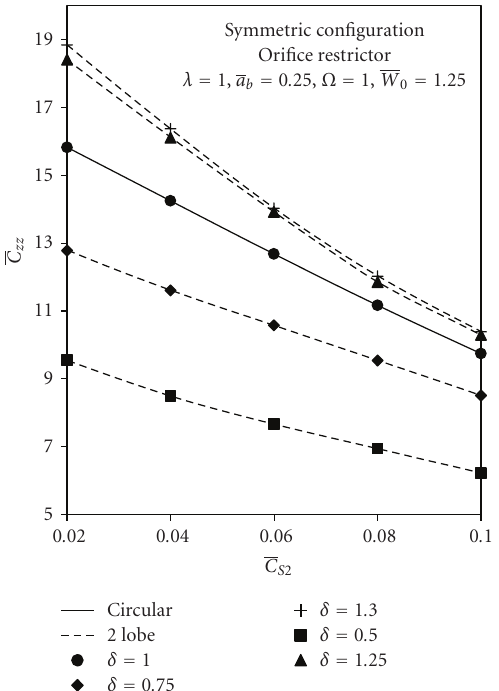
Figure 13: Variation of direct damping ( C zz ).